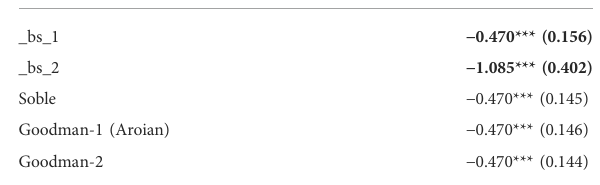
TABLE 11 Bootstrap and Soble